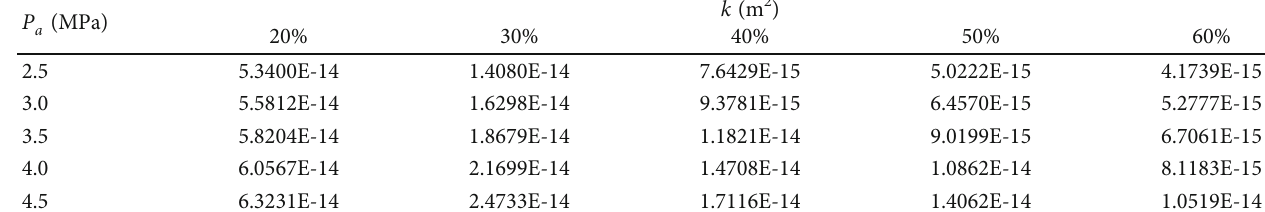
ff erent clay mineral proportions S . s under di ff erent clay mineral proportions S . a under di